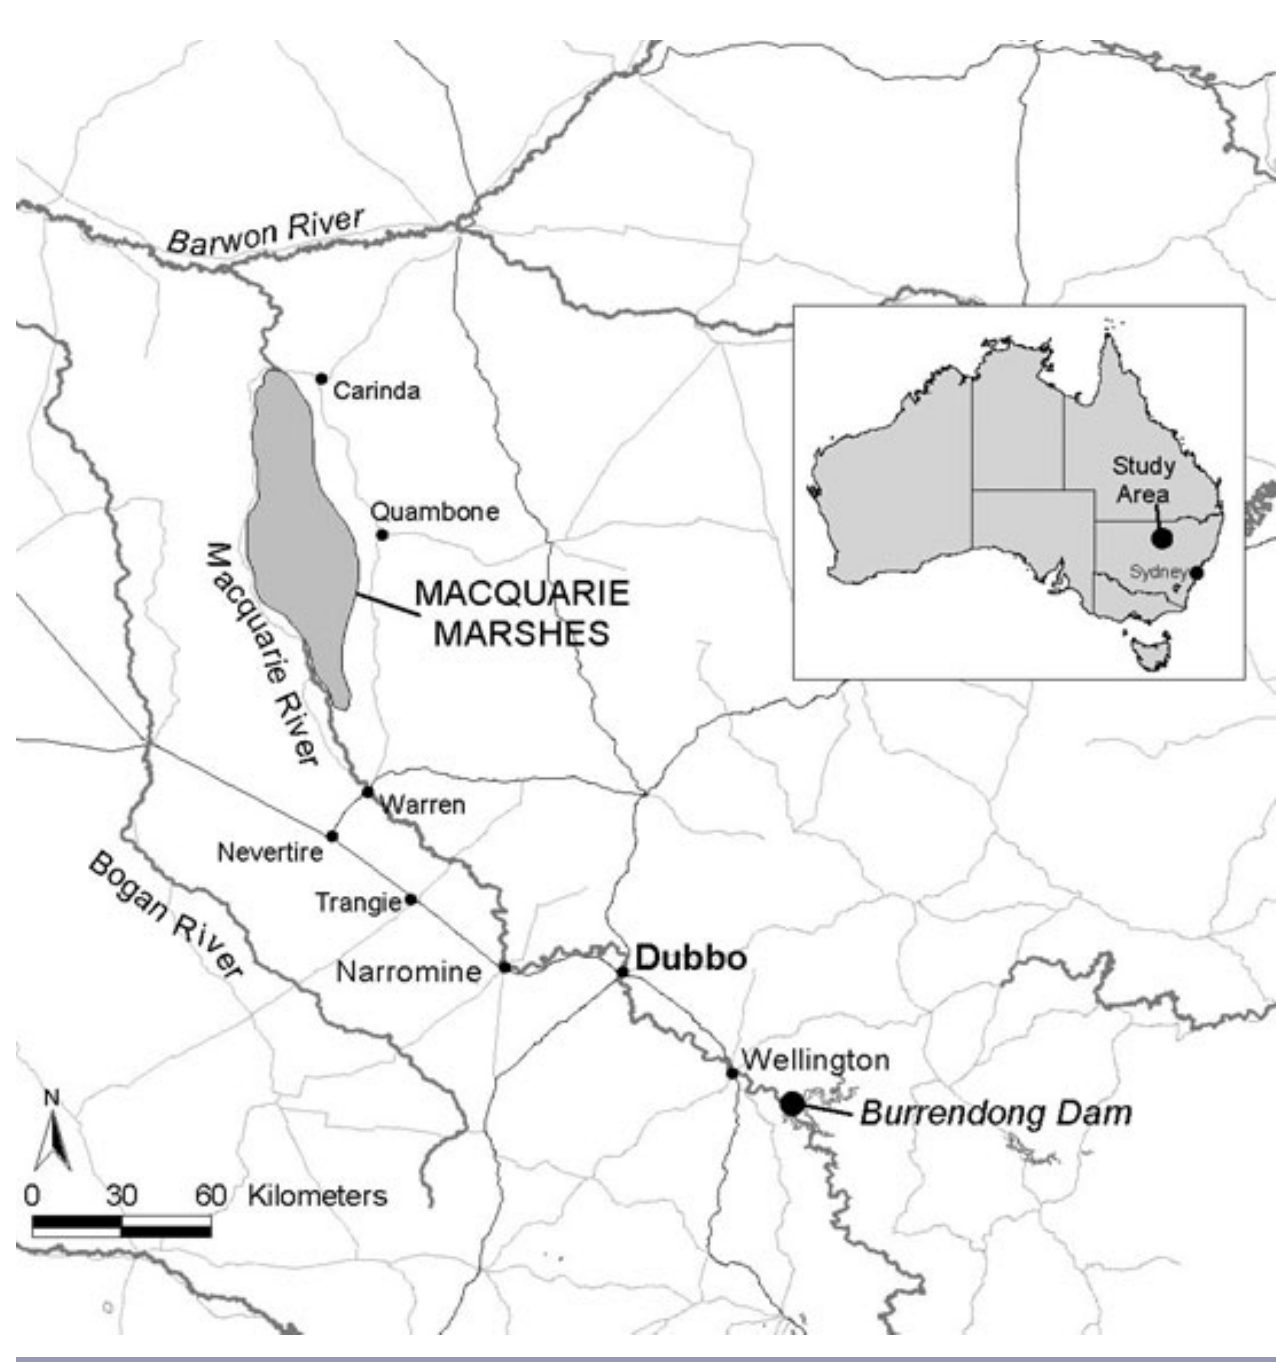
Fig. 1. Location map of the Macquarie